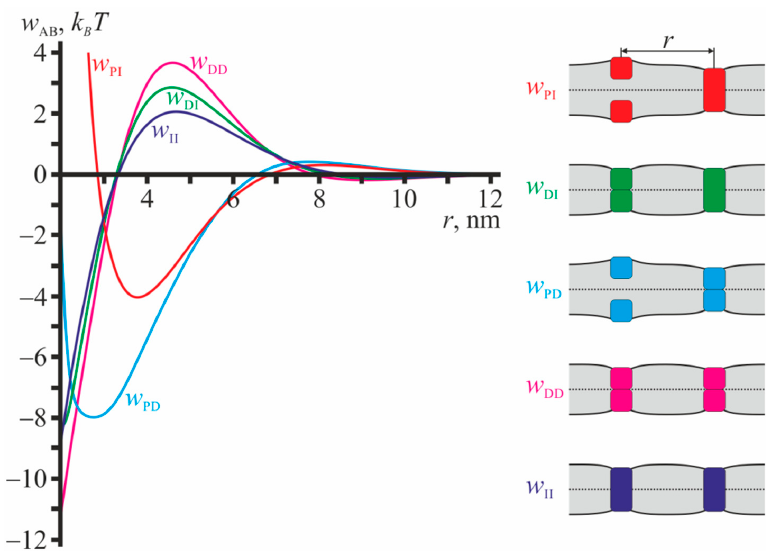
Figure 3. Profiles of pairwise interaction potentials for configurations that do not involve single gA monomers. Red curve— w PI ( r ); green curve— w DI ( r ); blue curve— w PD ( r ); magenta curve— w DD ( r ); dark blue curve— w II ( r ) (for transmembrane inclusion). The configurations are schematically illus- trated in the right-hand-side of the figure. The membrane is shown as light gray stripe; solid black lines correspond to surfaces of the upper and lower monolayers; dotted line corresponds to the monolayer interface; gA monomers are shown as squares; the transmembrane inclusions are shown as rectangles. The colors of the particles in the right-hand-side of the figure correspond to the colors of the interaction potential curves w AB .